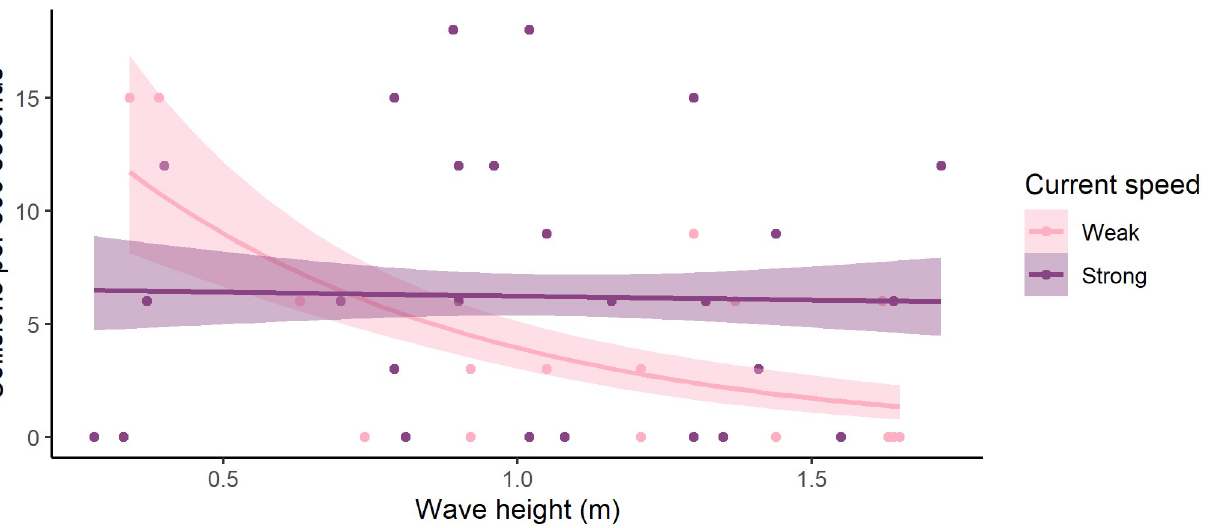
Shoal cohesion and position Salmon were less likely to shoal in larger waves (z = -2.023, DF = 74, P = 0.043) and when the current was southbound (z = -2.185, DF = 74, P = 0.029). The occurrence of shoaling differed between cameras with no shoaling observed in the “East”, “North”, and “Feed” cameras and